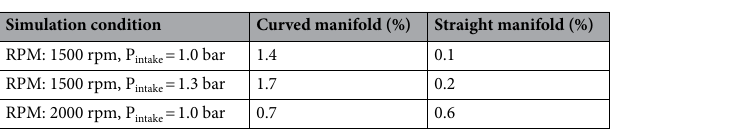
Table 3. Difference of volumetric efficiency between cylinders for different intake manifold.